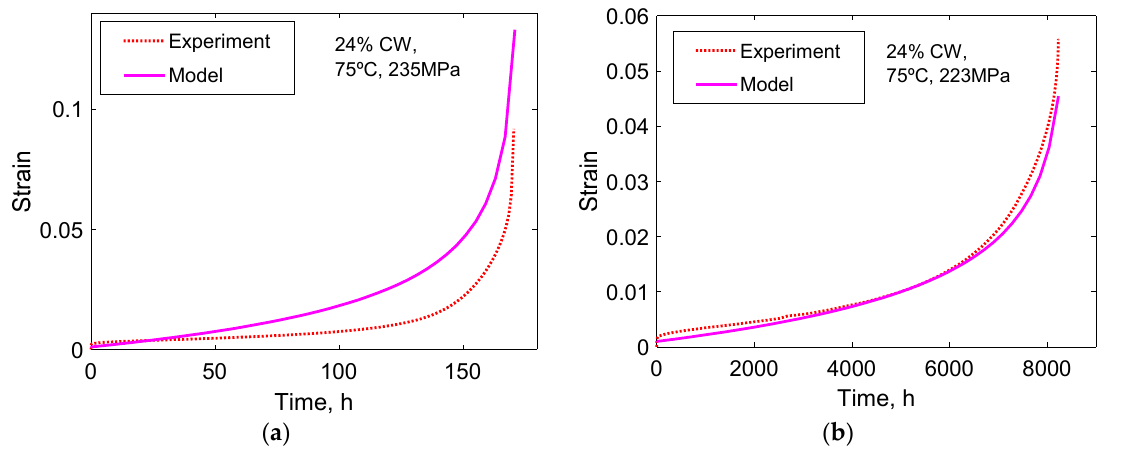
Figure 12. Creep strain versus time for 24% cold-work Cu-OFP at 75 °C, ( a ) 235 MPa, and ( b ) 223 MPa. Model results from integration of Equation (11). Redrawn with permission from ref. [16]. Copyright 2022 Elsevier.